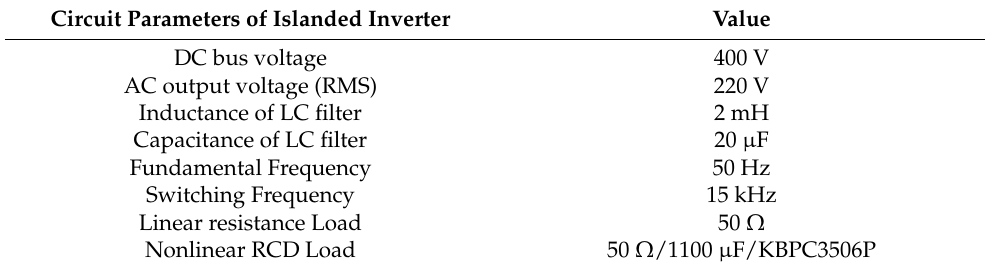
Table 1. Parameters of inverter circuit and testing